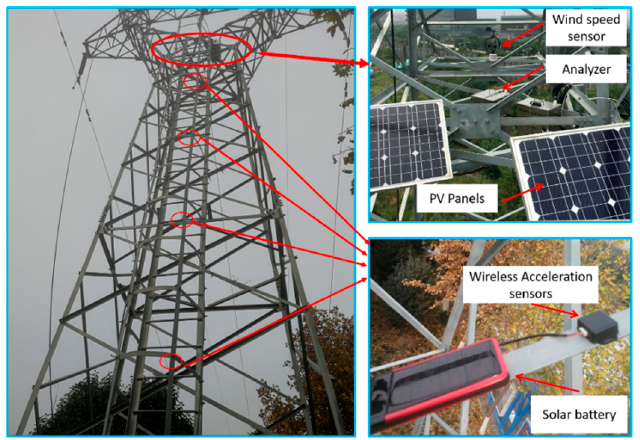
Figure 2. Photo of the field installation.